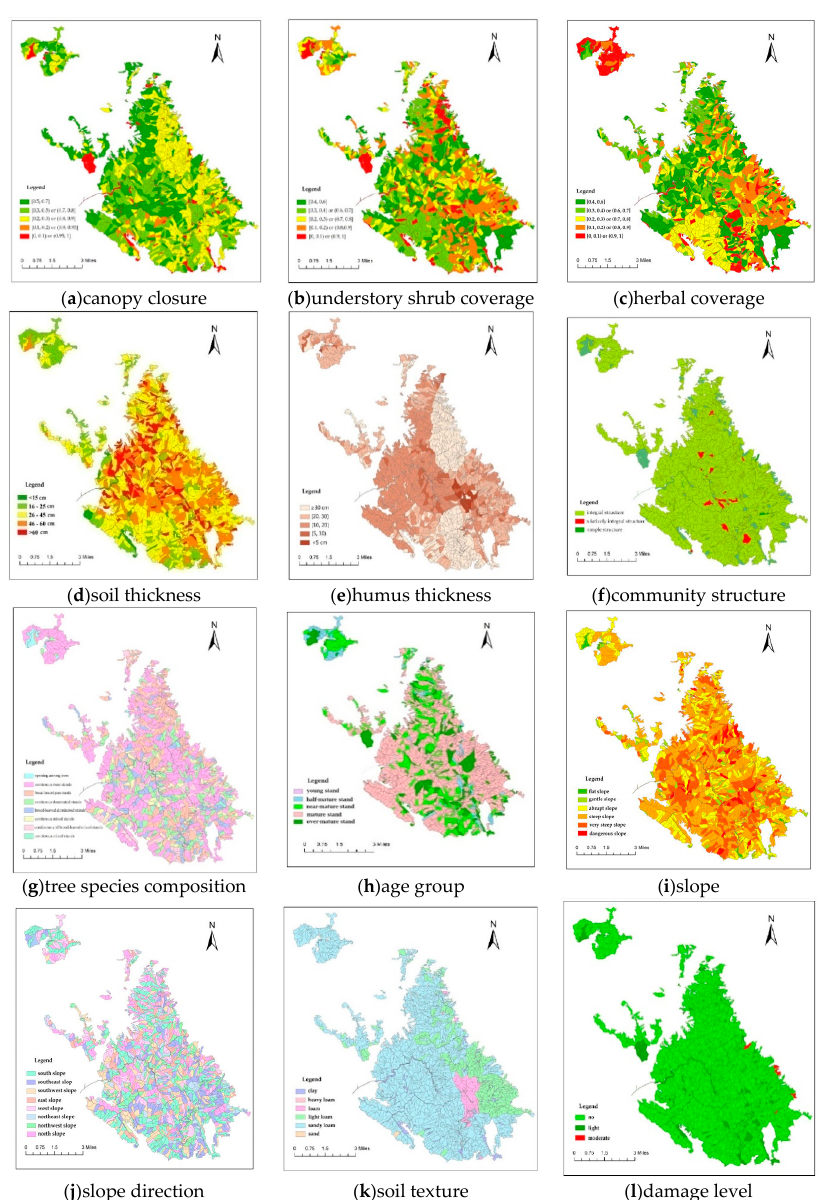
Figure 2. Maps of all indicators, ( a )canopy closure; ( b ) understory shrub coverage; ( c ) herbal coverage; ( d ) soil thickness; ( e ) humus thickness; ( f ) community structure; ( g ) tree species composition; ( h ) age group; ( i ) slope.